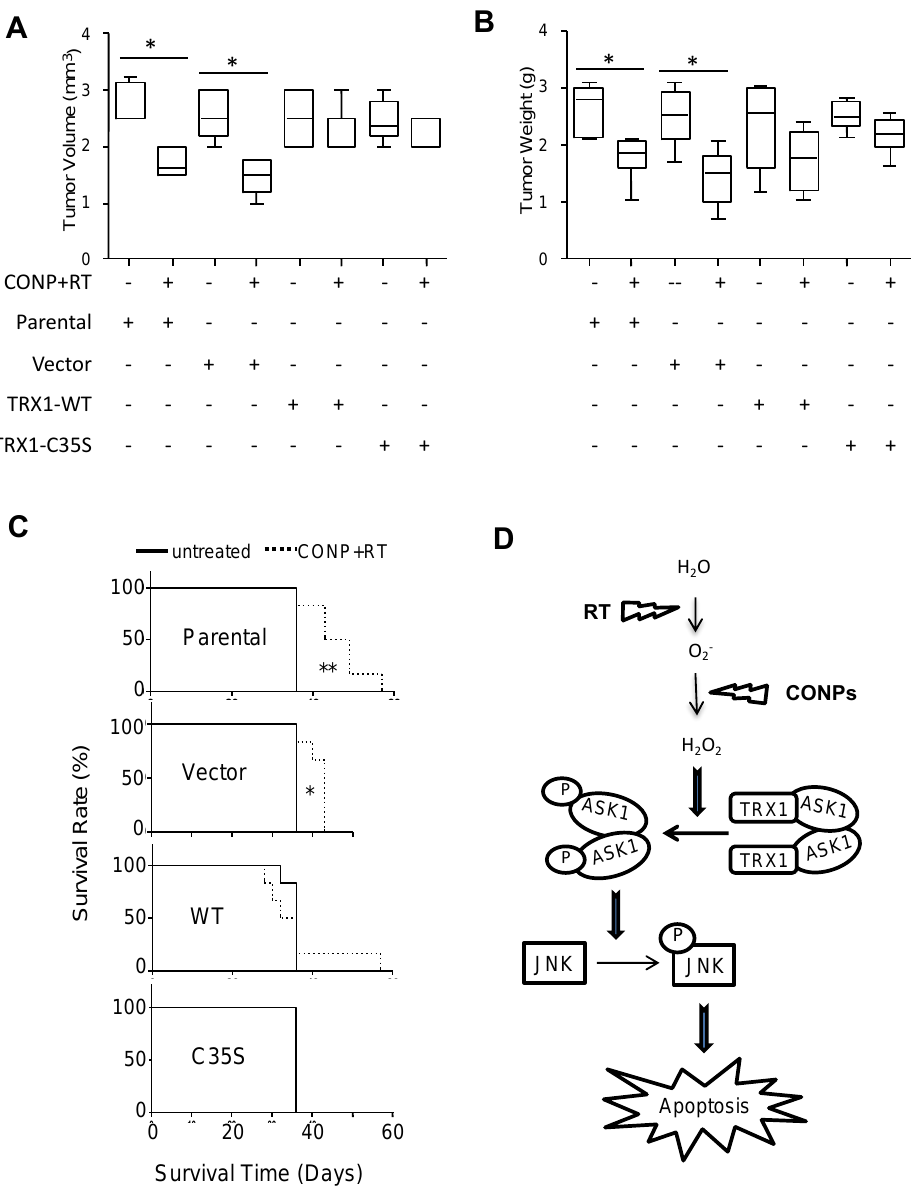
Figure 8. CONPs Fail to Sensitize Pancreatic Tumors to RT in the Absence of TRX1 Oxidation. The L3.6pl pancreatic cancer cell line overexpressing nothing (parental), empty vector, wild-type (WT) or mutant (C35S) TRX1 were implanted into nude mice followed by treatment with CONPs plus RT as described in the Materials and Methods section. At the time of death, the tumor volume and weight ( A , B ) as well as survival rate ( C ) were recorded. ** p < 0.01 with 10 days difference. * p < 0.01 with 7 days difference. ( D ) A model of mechanism of action.